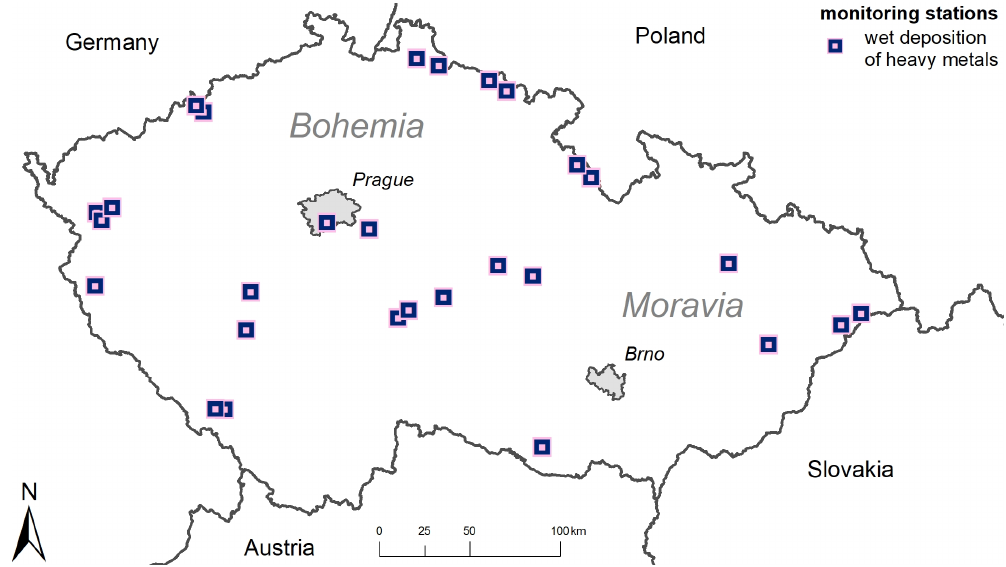
Figure 1. Map showing stations for monitoring heavy metals in precipitations used for creating wet deposition maps, situation in 2019.